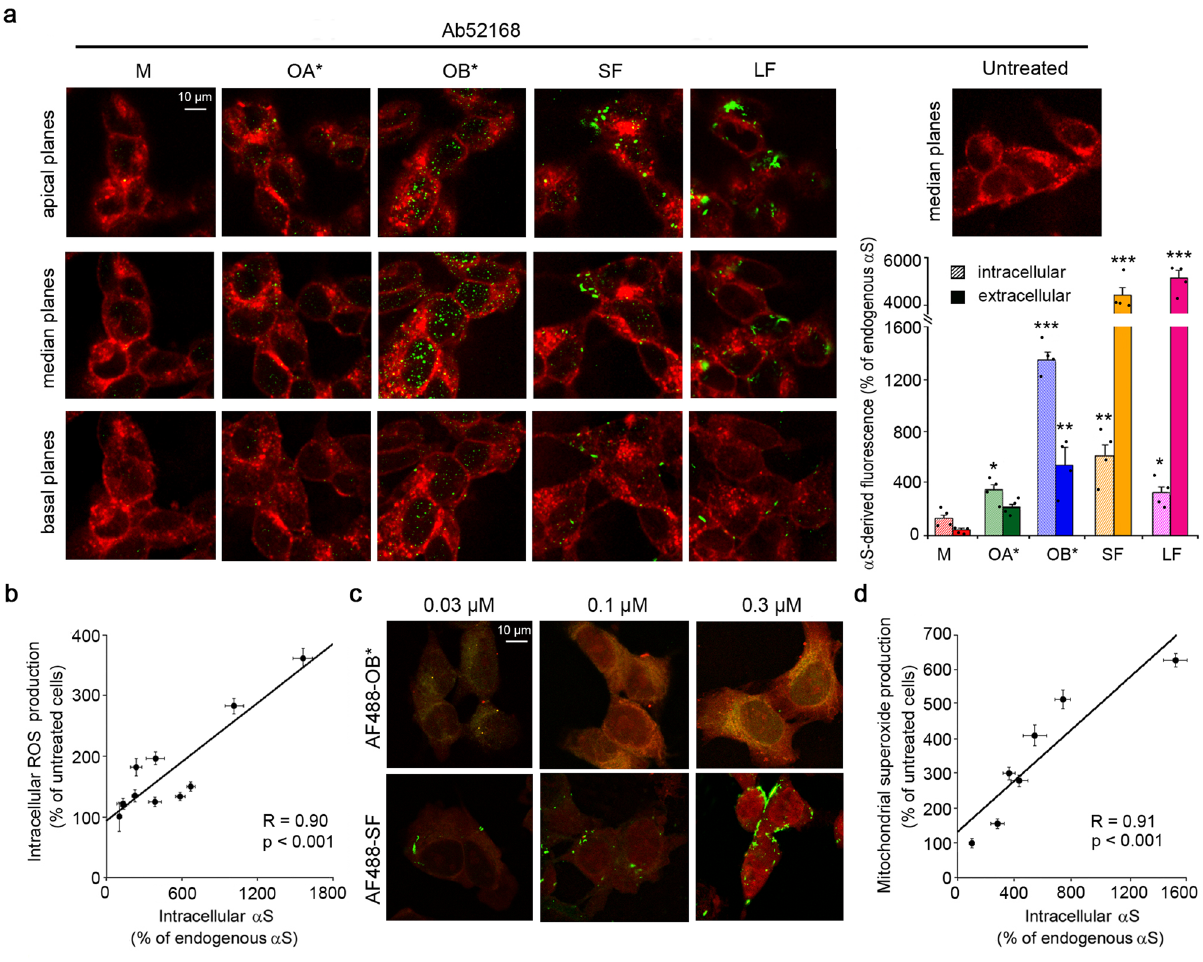
Fig. 2 α S fi brils are largely localized at the surface of the cellular membrane but ROS generation correlates with the intracellular α S pool. a Representative confocal scanning microscope images showing the basal, median, and apical sections of SH-SY5Y cells treated for 1 h with the indicated α S species at 0.3 μ M and the median sections of untreated cells. Red and green fl uorescence indicates the cell membranes and the α S species revealed with wheat germ agglutinin (WGA) and polyclonal anti- α S antibodies (Ab52168, Abcam), respectively. The histogram on the right reports a semi-quantitative analysis of the intracellular and extracellular α S-derived fl uorescence data expressed as the percentage of endogenous α S fl uorescence. b Dependence of ROS production on the intracellular α S-derived fl uorescences in SH-SY5Y cells treated with α S species. ROS values reported in Fig. S5 were plotted against the α S-derived fl uorescence values reported in Fig. S4d of cells treated with OB* and SF at the corresponding concentrations. c Representative confocal scanning microscope images showing mitochondrial superoxide production detected with MitoSOX probe in living SH-SY5Y cells. Red and green fl uorescence indicates MitoSOX staining and α S labeled with AF488 dye, respectively (six independent experiments with one internal replicate). d Dependence of mitochondrial superoxide production on the intracellular AF488-derived fl uorescence signal in SH-SY5Y cells treated with α S species. Experimental errors are S.E.M. ( n = 4 with three internal replicates in panels ( a ), ( b ); n = 6 in panel ( d ) with one internal replicate). Samples were analyzed by one-way ANOVA followed by Bonferroni ’ s multiple comparison test relative to untreated cells (in panel a , * P < 0.05, ** P < 0.01, *** P < 0.001; in panel b , P < 0.001; in panel d , P < 0.001). A total of 200 – 250 cells were analyzed per